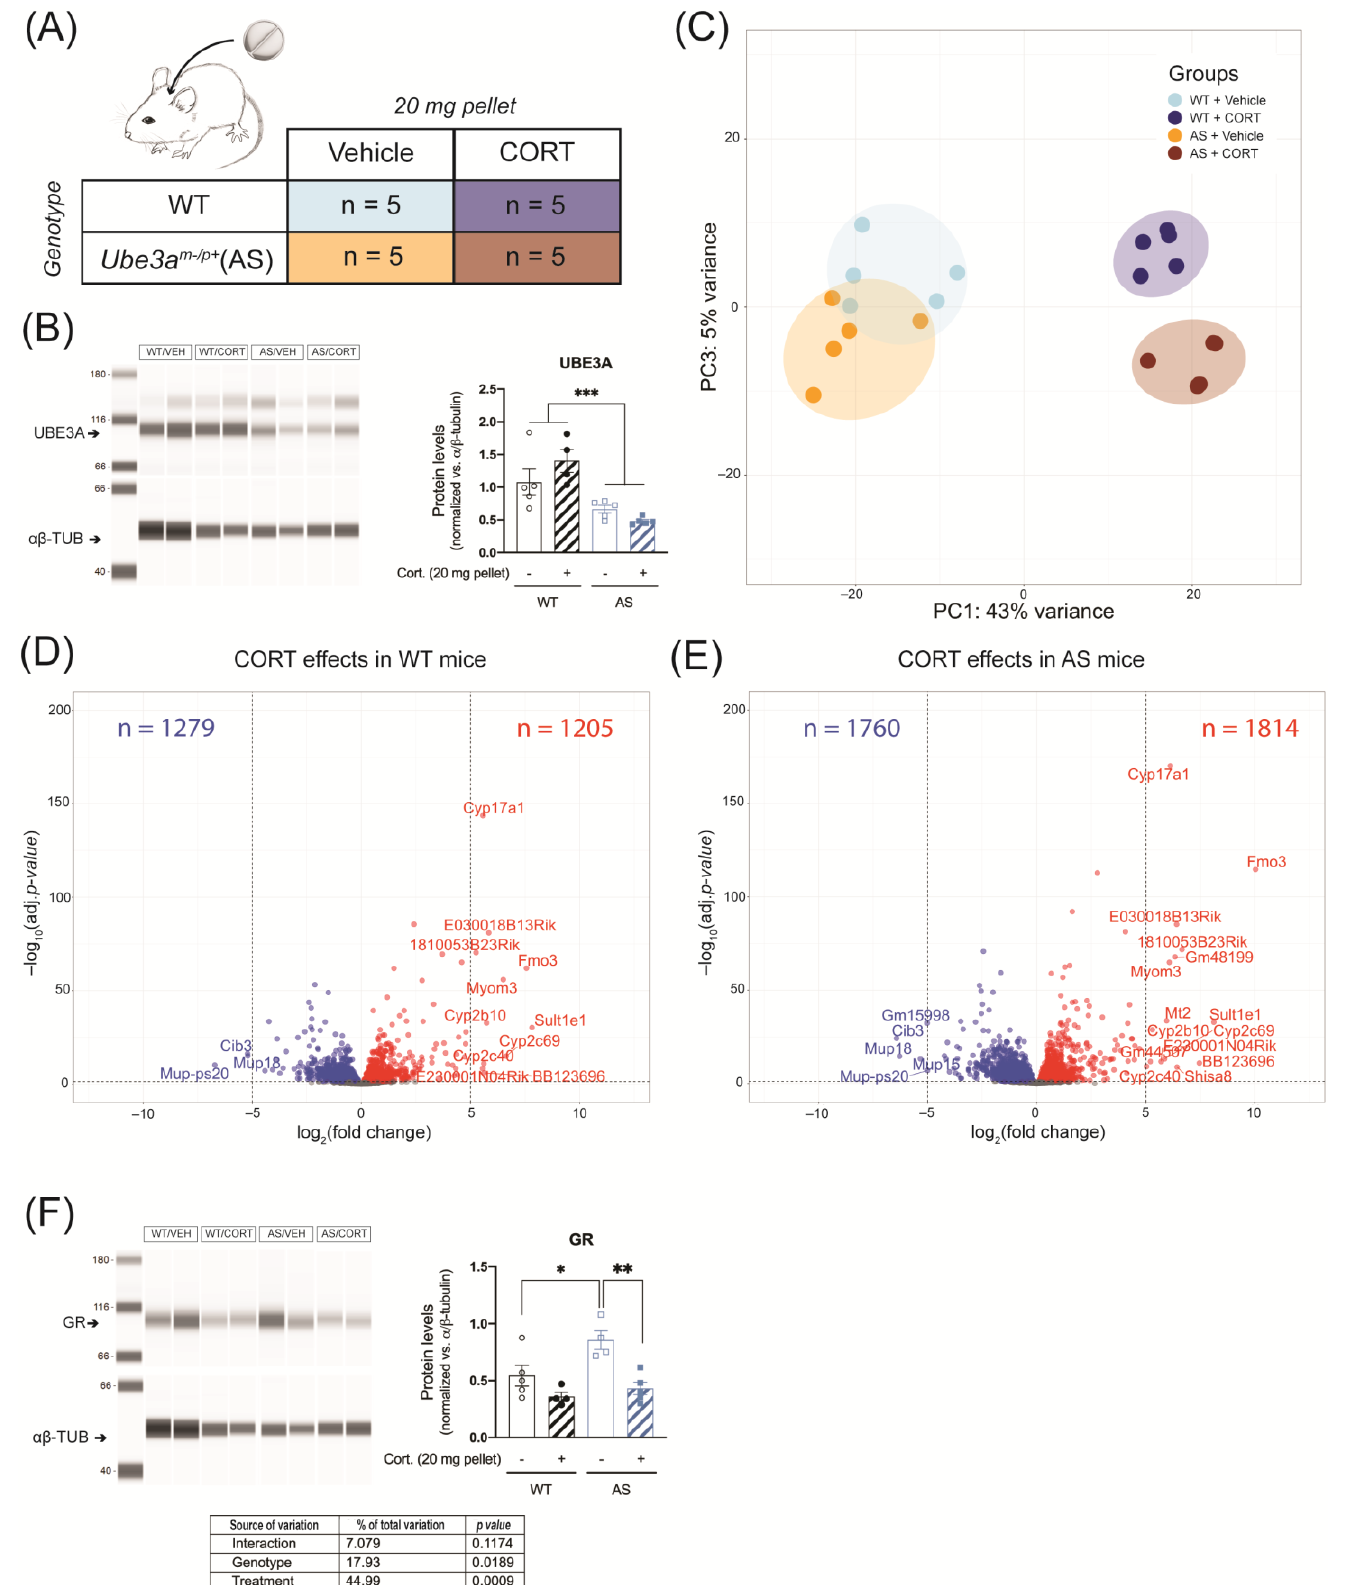
Figure 6. Continuous corticosterone exposure slightly alters liver GR signaling in UBE3A-deficient AS mice. ( A ) WT and AS mice were subcutaneously implanted with a vehicle pellet or a slow-release corticosterone (20 mg) pellet for five days ( n = 5/group). ( B ) UBE3A protein expression in the liver of WT and AS mice after continuous treatment with vehicle or corticosterone, normalized against